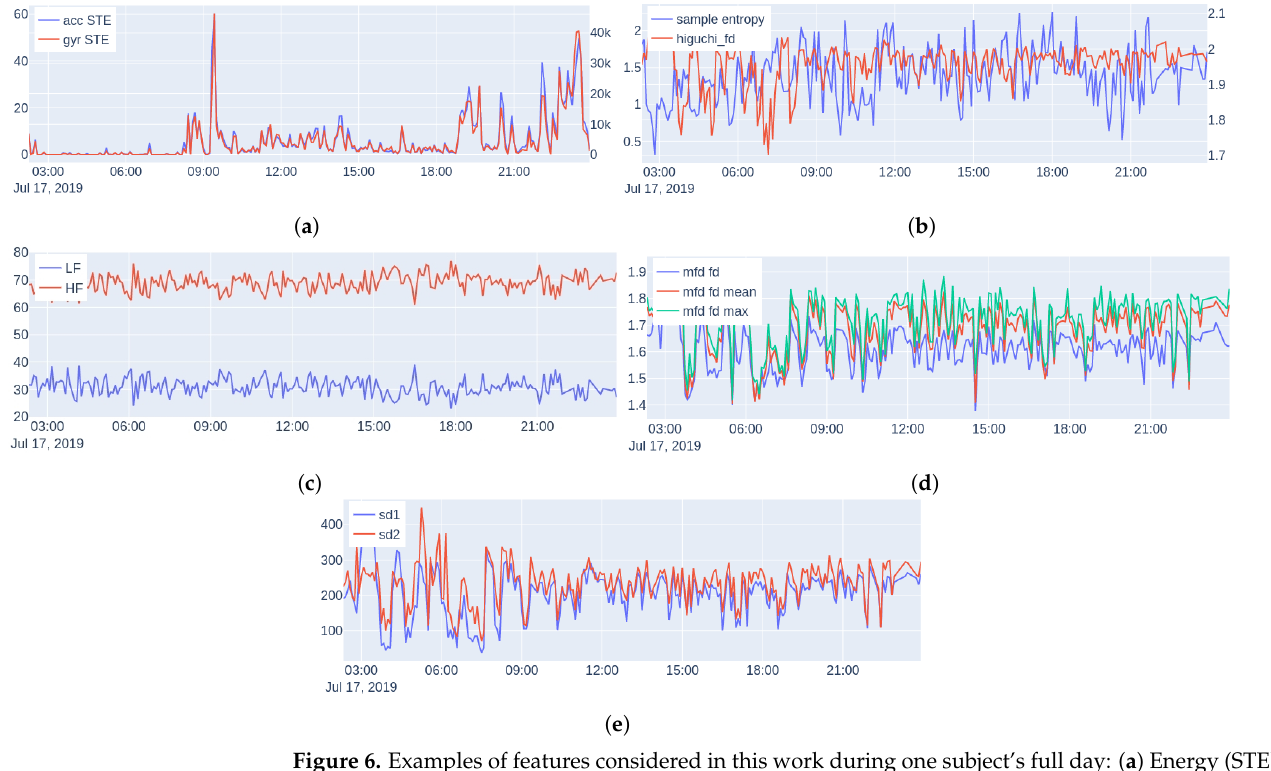
Figure 6. Examples of features considered in this work during one subject’s full day: ( a ) Energy (STE) of the euclidean norm of acc and gyr ; ( b ) Sample entropy and Higuchi fractal dimension of HRV; ( c ) Normalized LF and HF power of HRV; ( d ) MFD fractal dimension, mean MFD and max MFD of HRV; ( e ) Poincare SD1 and SD2 of